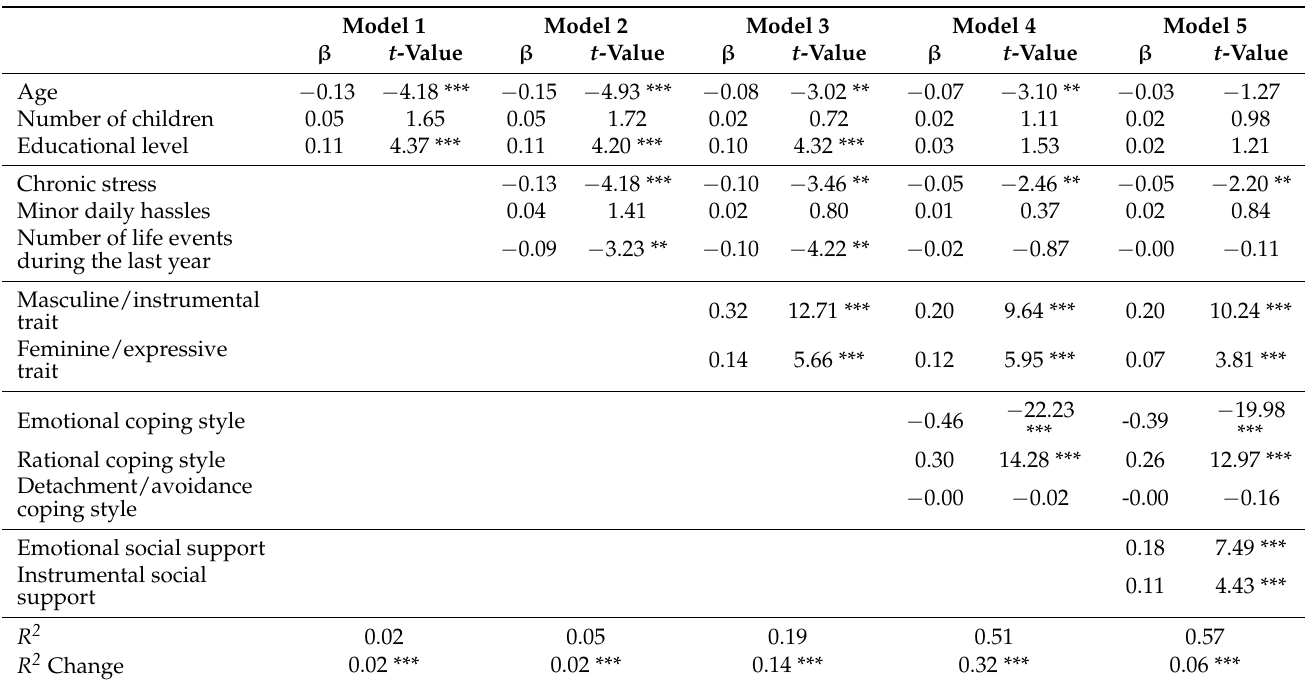
Table 4. Summary of the hierarchical regression with eudaimonic well-being as the dependent variable for men.